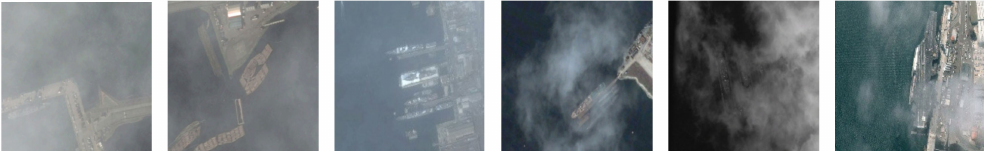
Figure 3. The ship objects covered by clouds and fogs in high-resolution remote sensing